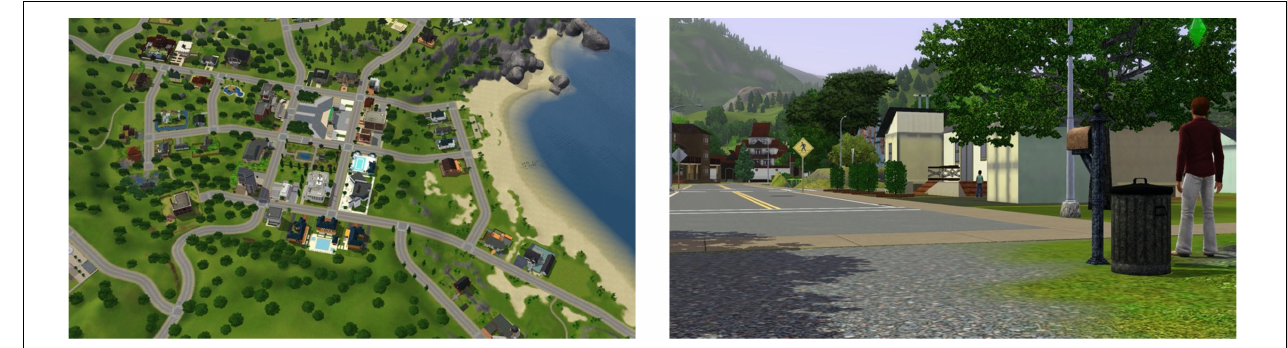
FIGURE 1 | Navigation memory task. Left: Bird’s eye view of the virtual town. Right: Starting point view as seen by participants. Sim City and screenshots of it are licensed property of Electronic Arts, Inc. Reproduced with permission.